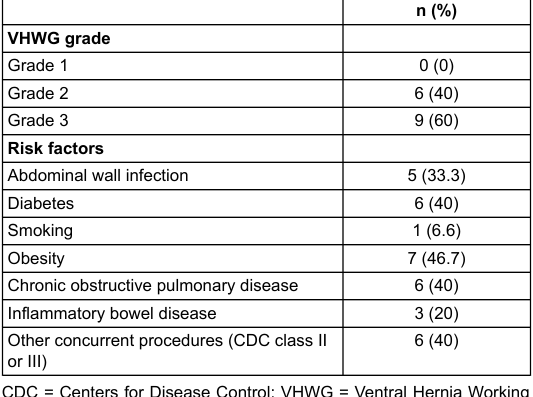
Table 5: Risk factors associated with surgical site infections (n = 15).